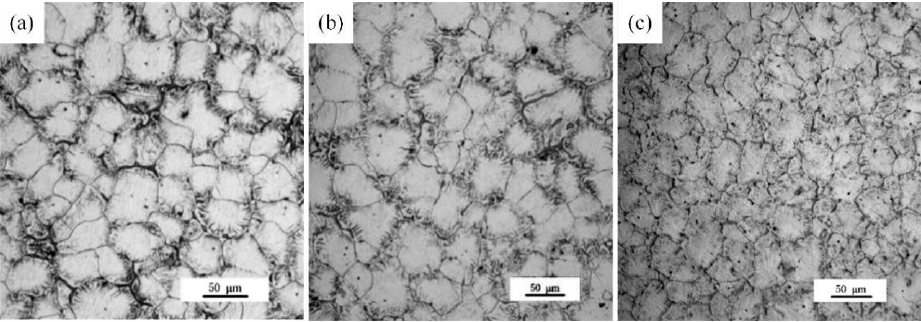
Figure 1. Optional microstructure of the as-cast Mg-xGd alloys: ( a ) Mg-1Gd (AC (as-cast)), ( b ) Mg-3Gd (AC), and ( c ) Mg-5Gd (AC) .